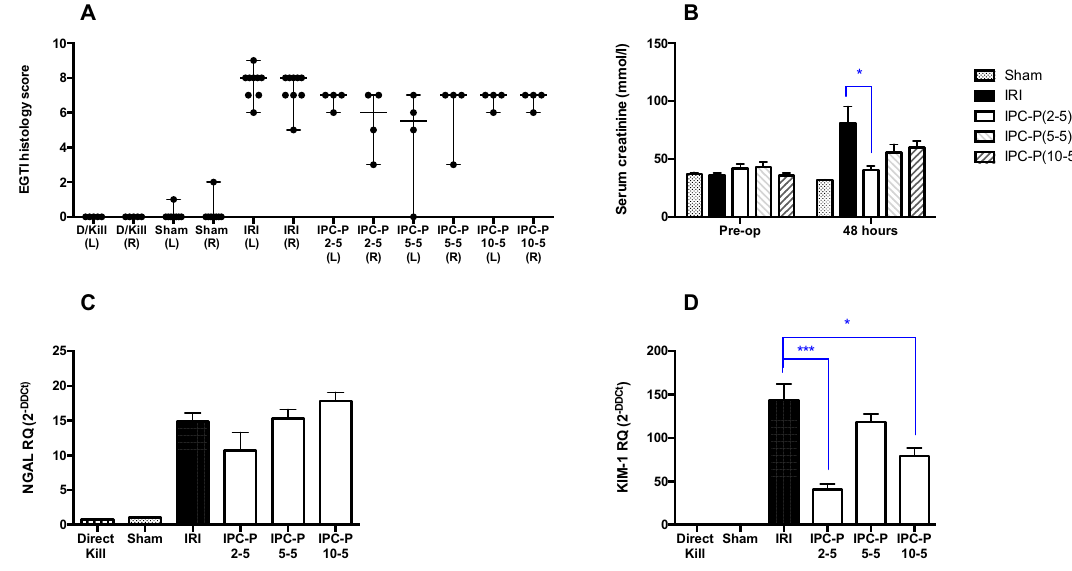
Figure 1. Effect of localised pulsatile IPC on EGTI score, serum creatinine, and renal injury markers NGAL and KIM-1. (A) Renal cortex sections were prepared from kidneys harvested 48 h after recovery from 45 min bilateral IRI, and after 3 localized pulsatile IPC regimens (comprising 3 cycles of 2, 5, or 10 min ischaemia alternated with 5 min of reperfusion (labelled IPC-P 2–5, IPC-P 5–5, and IPC-P 10–5 respectively) prior to IRI, Sections were stained with H&E and scored for Endothelial, Glomerular, Tubular, and Interstitial cell damage. EGTI Histology scores are plotted as median and range. (B) Serum creatinine was measured pre-operatively